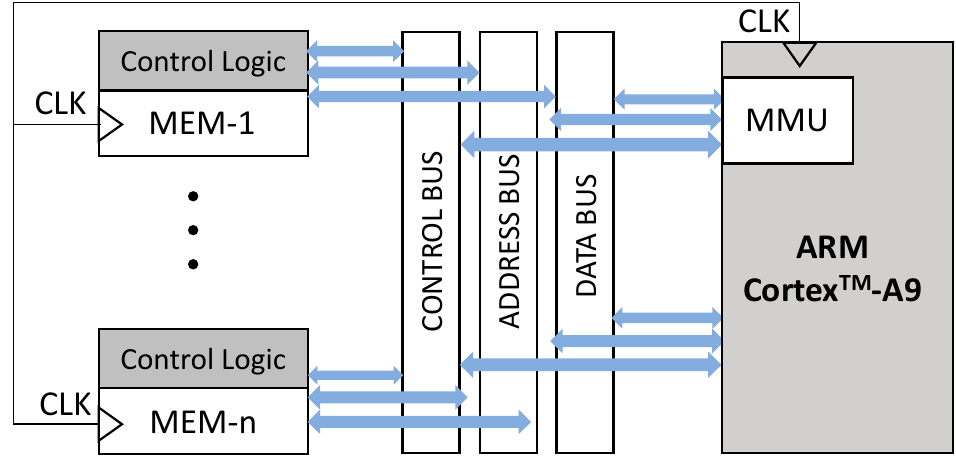
Figure 3. The general scheme of the processing system of AP-SoC.